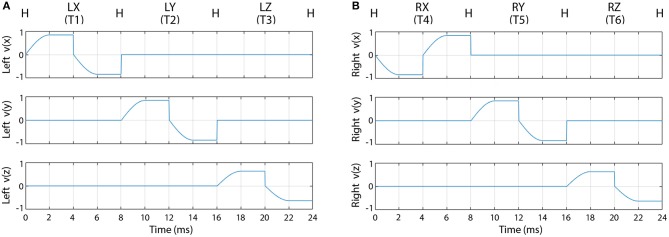
Velocity trajectories used for the offline part of the experiment. The figure represents the velocity of the left (A) and right (B) virtual hand movement during the first sub-block (pause periods are not presented). Label “H” indicates the left (A) or right (B) hand at the home position. Labels LX, LY, LZ and RX, RY, RZ indicate X, Y, and Z, positions of the left (A) and right (B) hand, respectively.